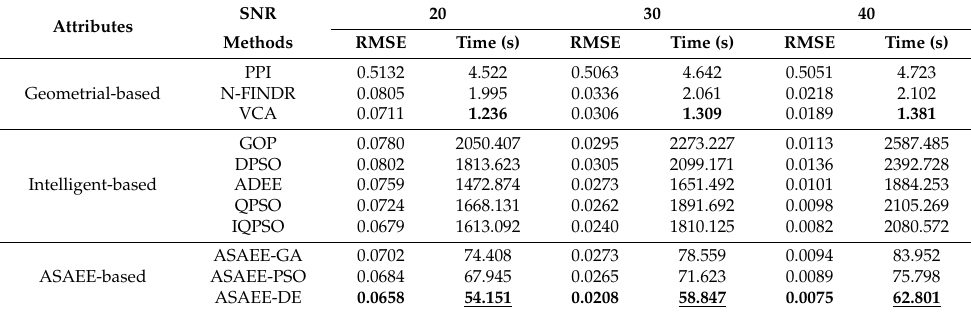
Table 2. Comparison of the proposed ASAEE framework with other algorithms on DS2.